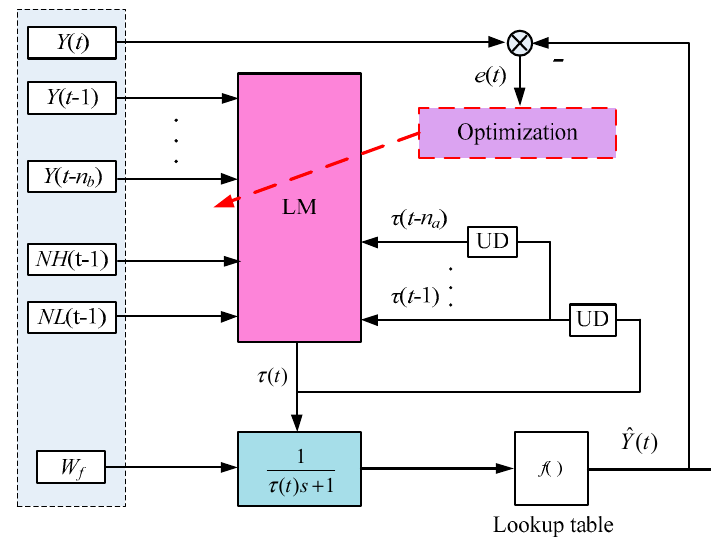
Figure 1. The training schematic of self-tuning Wiener model related to one examined engine output.